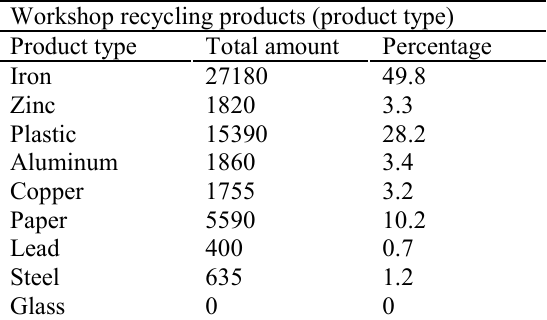
Table 5. Types of recycled materials in workshops Workshop recycling products (product